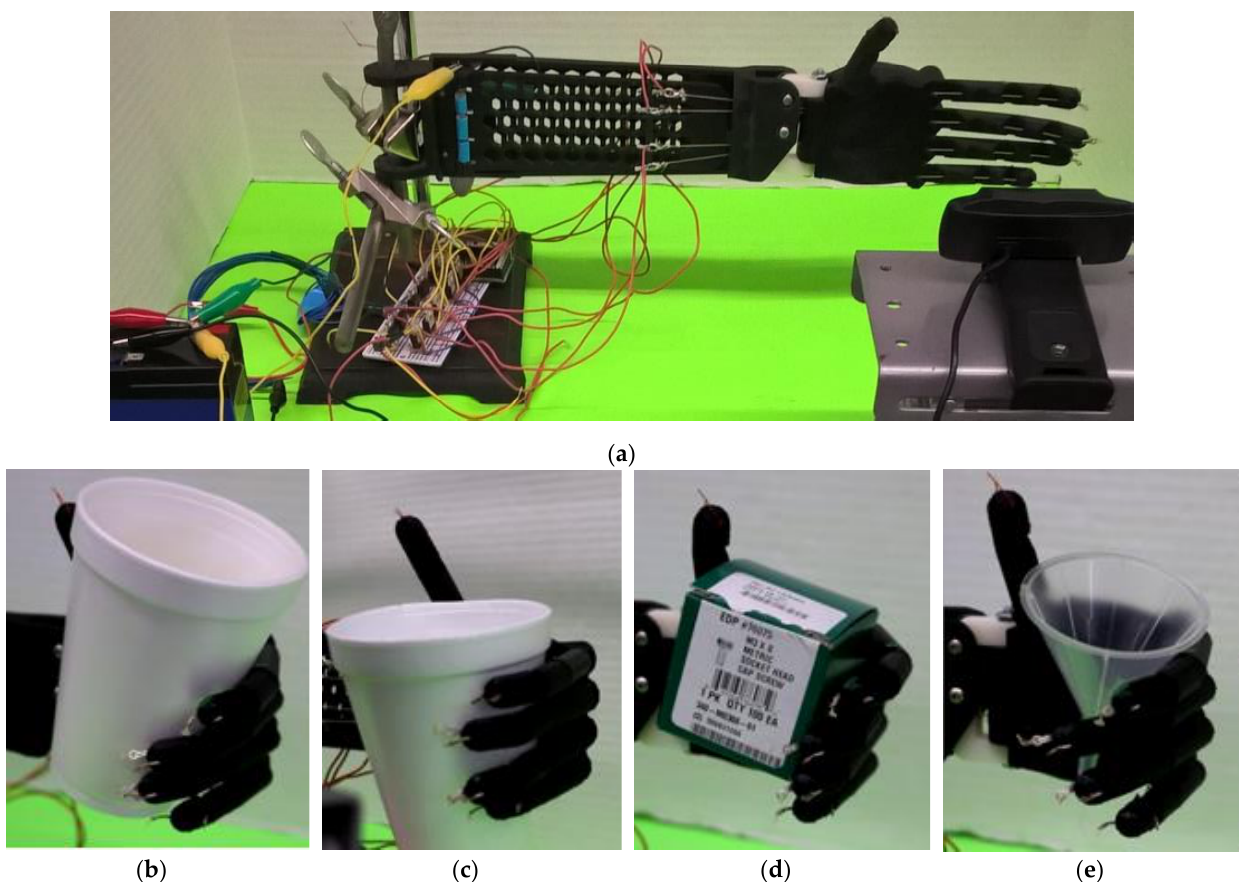
Figure 11. Vertical grasping of objects: ( a ) experimental setup; ( b ) empty cup, 3 g; ( c ) cup with water, 133 g; ( d ) box, 12.67 g and ( e ) funnel, 7.3 g. Since the thumb is not in use, the gripping force is generated purely from the main fingers. As shown in ( c ), the thumb is not assisting the grip. It should also be noted that the increased weight from the water causes the cup to sink in the hand’s grip. Heating cycle remained the same as the horizontal grasping, with 0.7 A (flexors) for 2 s (to flex the fingers, followed by 0.2 A (flexors) for 10 s (holding) and then 0.5 A (extensors) for 8 s (to extend the fingers).